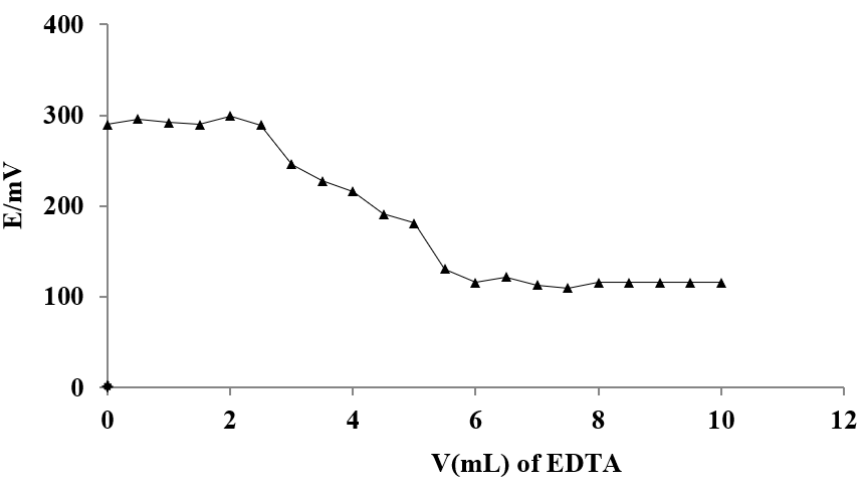
Figure 11. Potentiometric titration curve of standard solution of Hg(NO 3 ) 2 with EDTA solution using our proposed electrode as an indicator electrode at optimized conditions. The concentrations used are mentioned in the text.